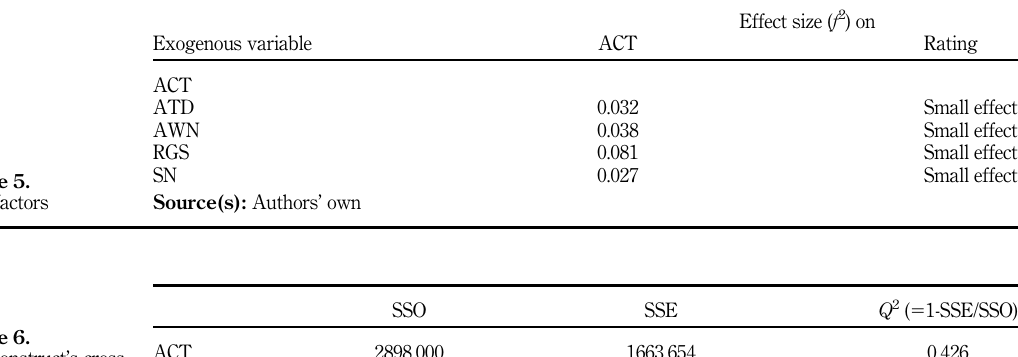
Table 6. The construct ’ s cross- validated redundancy